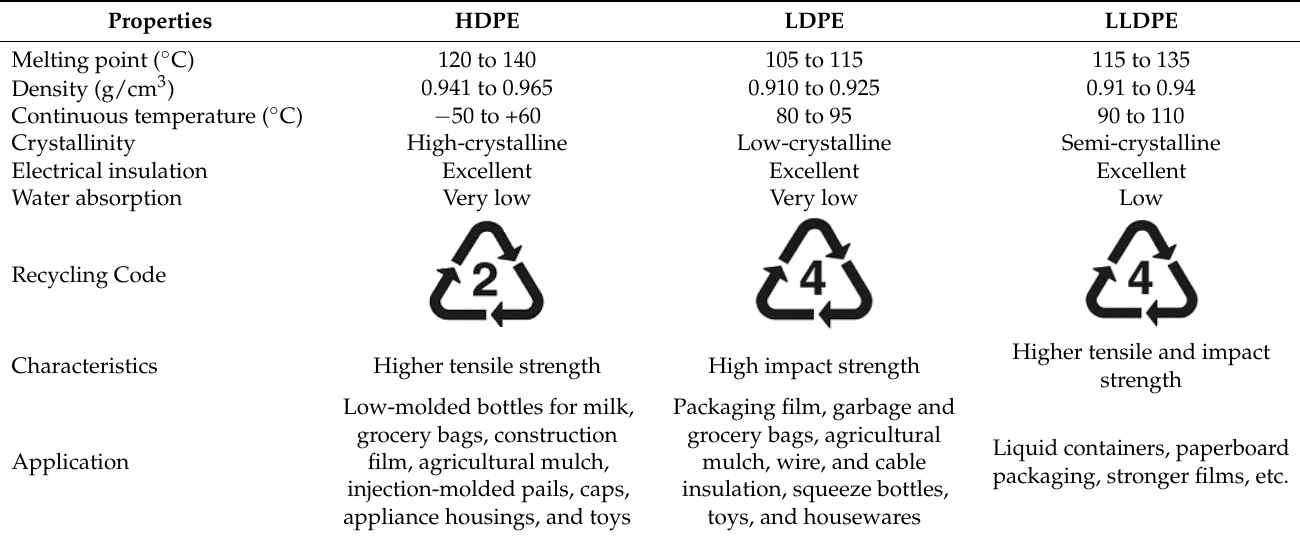
Table 3. Properties of polyethylene compound [56–58].